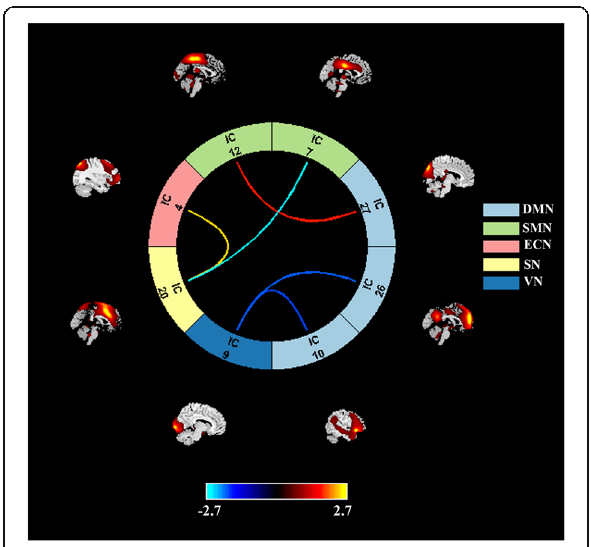
Fig. 2 Significant differences in the network connectivity in the default mode network (DMN), sensorimotor network (SMN), executive control network (ECN), salience network (SN), visual network (VN) between mTBI+PTH group and mTB-PTH